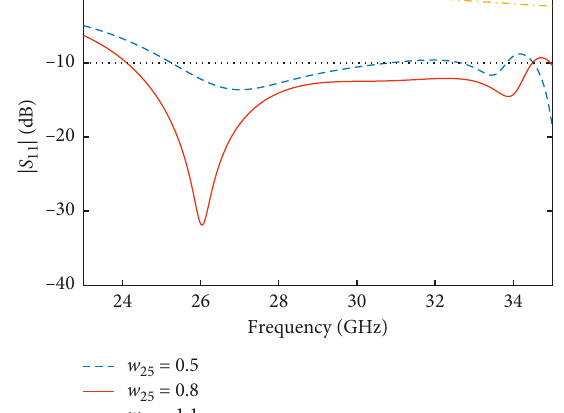
Figure 6: Effects of various w